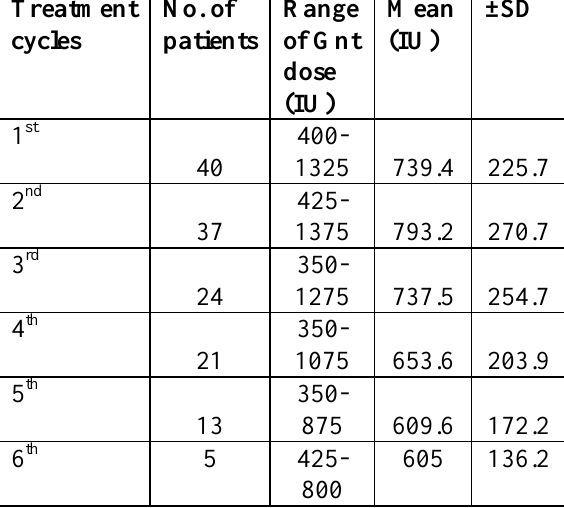
Table-5: Patients distribution according to the total dose of r-FSH used in each cycle Treatment cycles